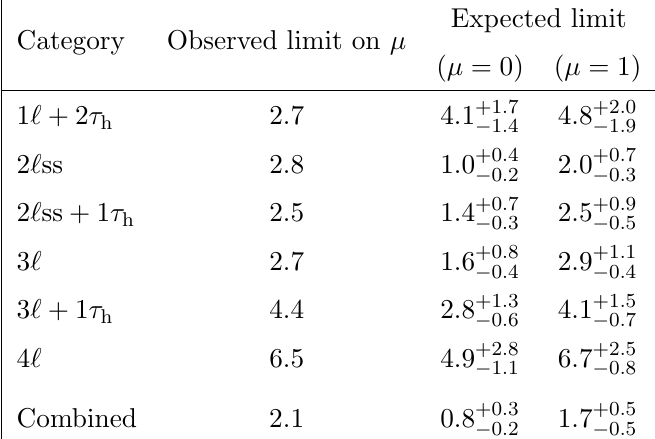
Table 6 . The 95% CL upper limits on the ttH signal rate, in units of the SM ttH production rate, obtained in each of the categories individually and for the combination of all six event categories.